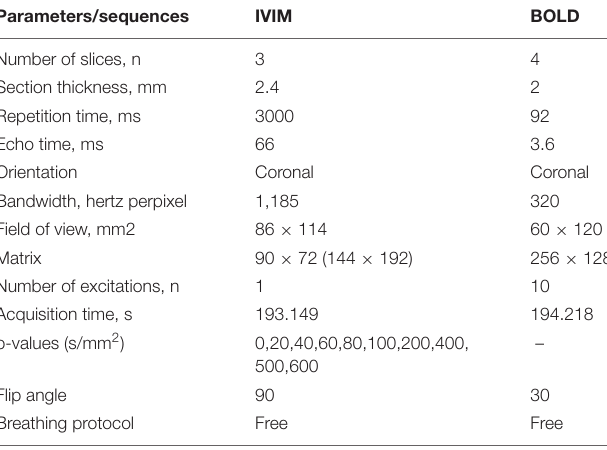
TABLE 1 | Parameters and sequences of IVIM and